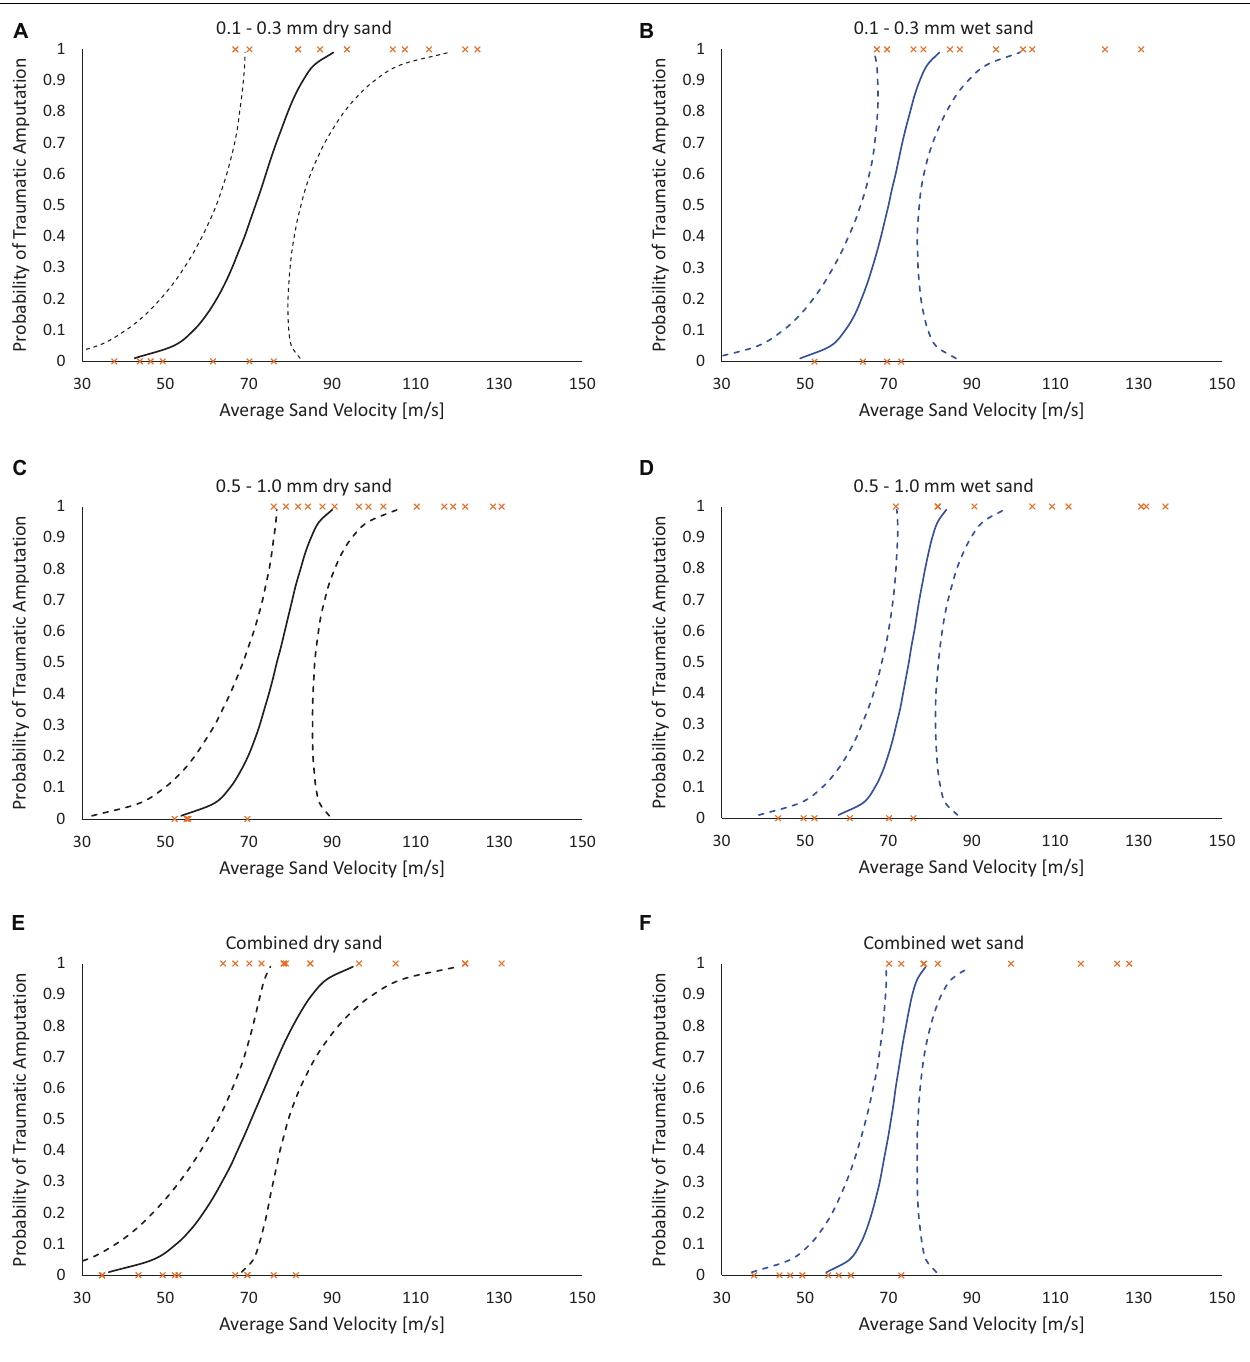
FIGURE 6 | Traumatic amputation (as per Figures 5C,D ) risk curves as a function of average sandy gravel velocity. (A) 0.1–0.3 mm dry sandy gravel. (B) 0.1–0.3 mm wet sandy gravel. (C) 0.5–1.0 mm dry sandy gravel. (D) 0.5–0.1 mm wet sandy gravel. (E) Combined (ideally distributed) dry sandy gravel. (F) Combined (ideally distributed) wet sandy gravel. 95% CI represented with dashed